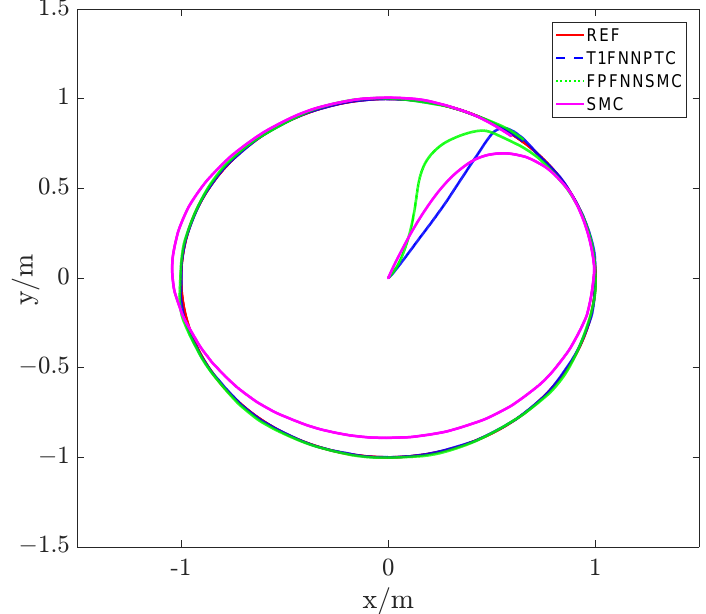
Figure 6. Circular trajectory tracking.